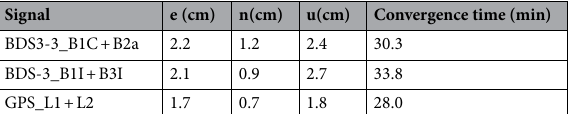
Table 8. The following can be inferred from the above results.